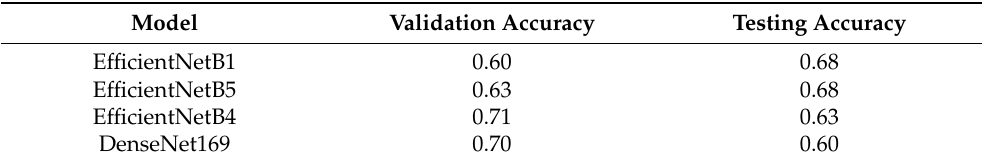
Table 4. Performance of the 4 best out of 40 pretrained networks for the defect classifier after 5 epochs. Model